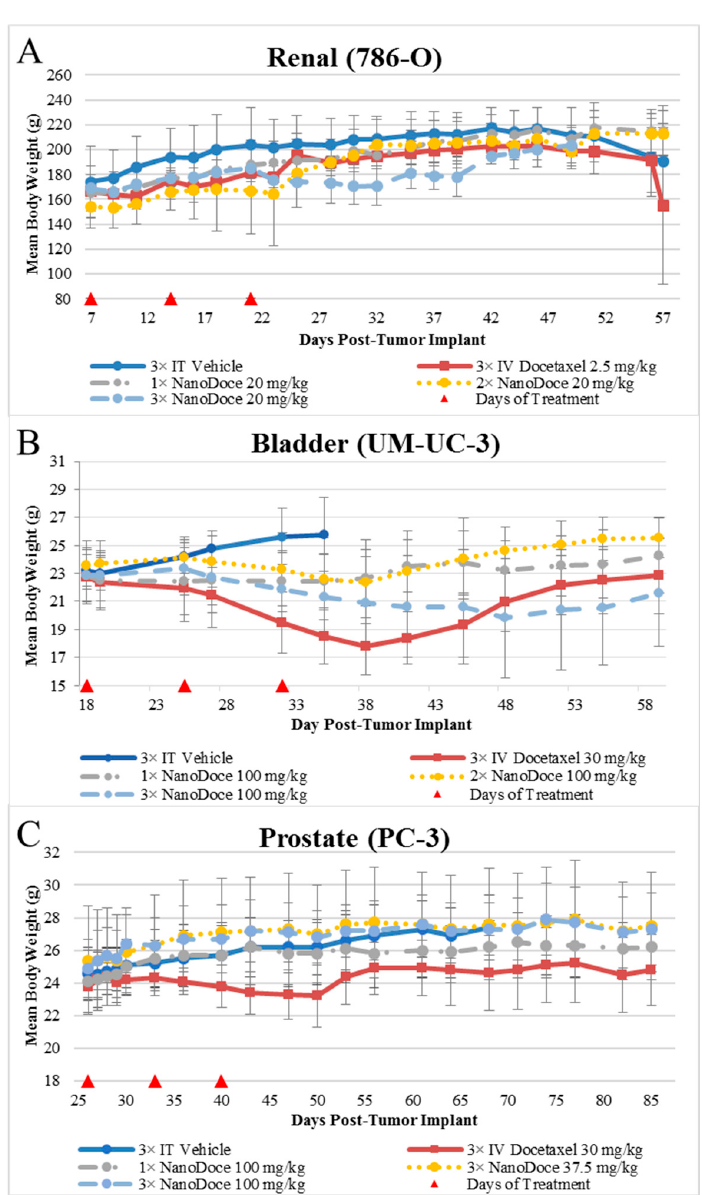
Figure 2. Mean body weights from treatment initiation through study end. Data plotted through point when ≥ 50% of animals in group survived. Error bars = ±1 Std. Dev. ( A ) Female rats implanted with 786-O tumors; n = 3/group. ( B ) Female mice implanted with UM-UC-3 tumors; n = 9 or 10/group. ( C ) Female mice implanted with PC-3 tumors; n = 10/group.